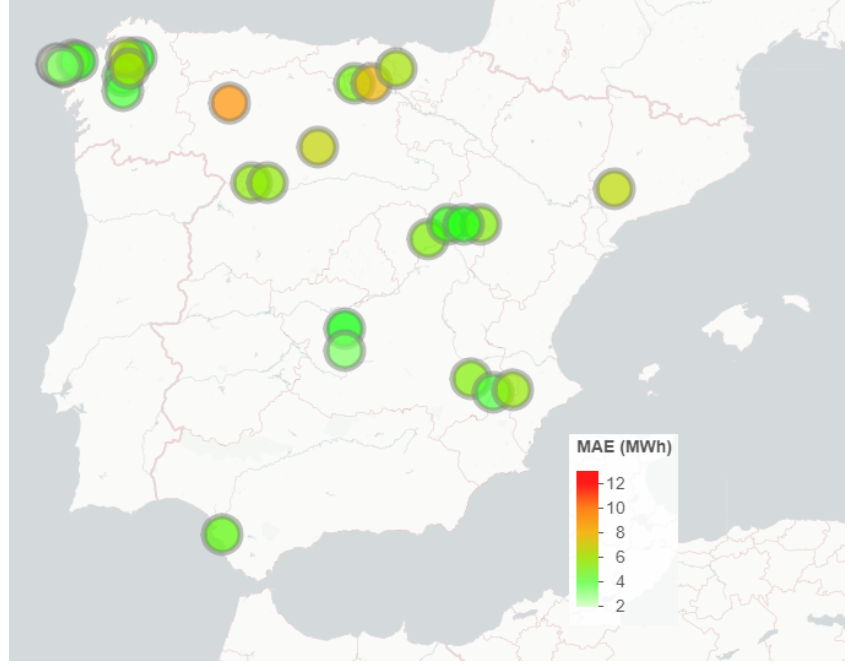
Figure 3. RMAE error in the day-ahead forecast according to the location of the wind farms under study.